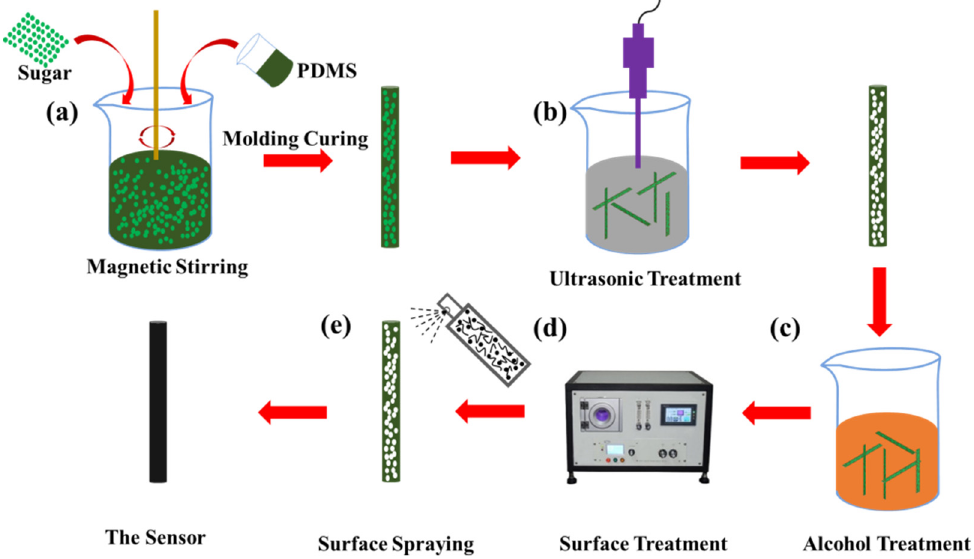
Figure 1. The preparation process of the flexible strain sensor: ( a ) matrix preparation by solution mixing; ( b ) ultrasonic treatment of the matrix in distilled water employed to obtain the porous structure; ( c ) cleaning of the matrix using alcohol; ( d ) the surface of the matrix is treated with isoxic ions to improve the surface activity; ( e ) strain sensors obtained by spraying.